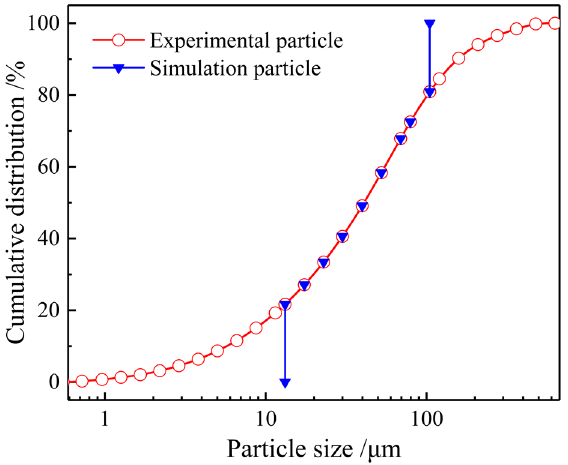
Figure 4. Simulated particle size distribution curve.